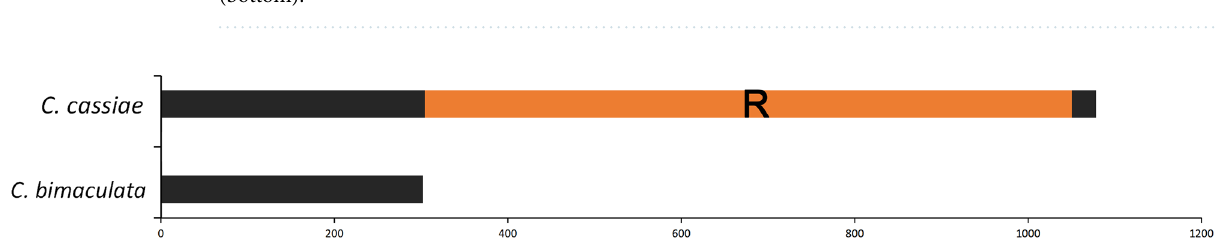
Figure 2. Relative synonymous codon usage (RSCU) of mitogenomes for C. cassiae (top) and C. bimaculata (bottom).